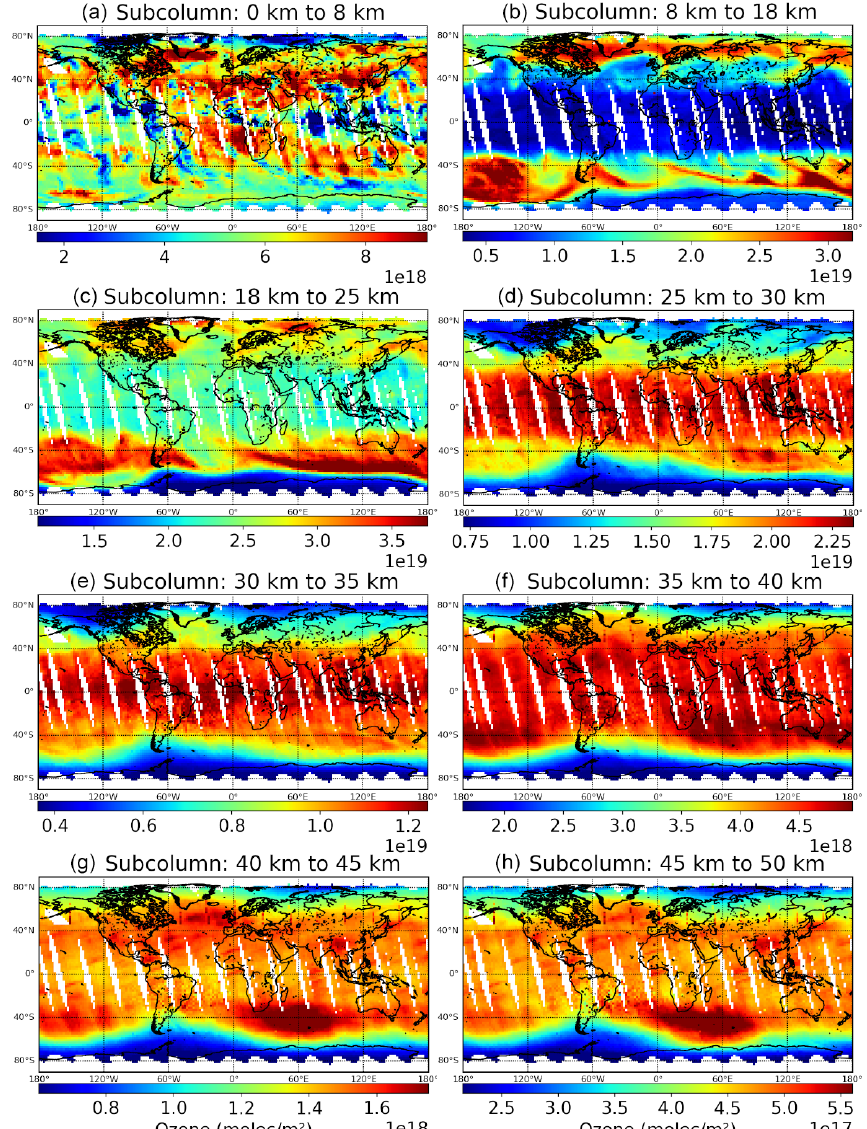
Figure 11. TROPOMI ozone subcolumns for selected atmospheric layers for 1 October 2018. Each subcolumn has its own colour scale. The vertical thicknesses of the layers roughly approximate the vertical resolution of the ozone